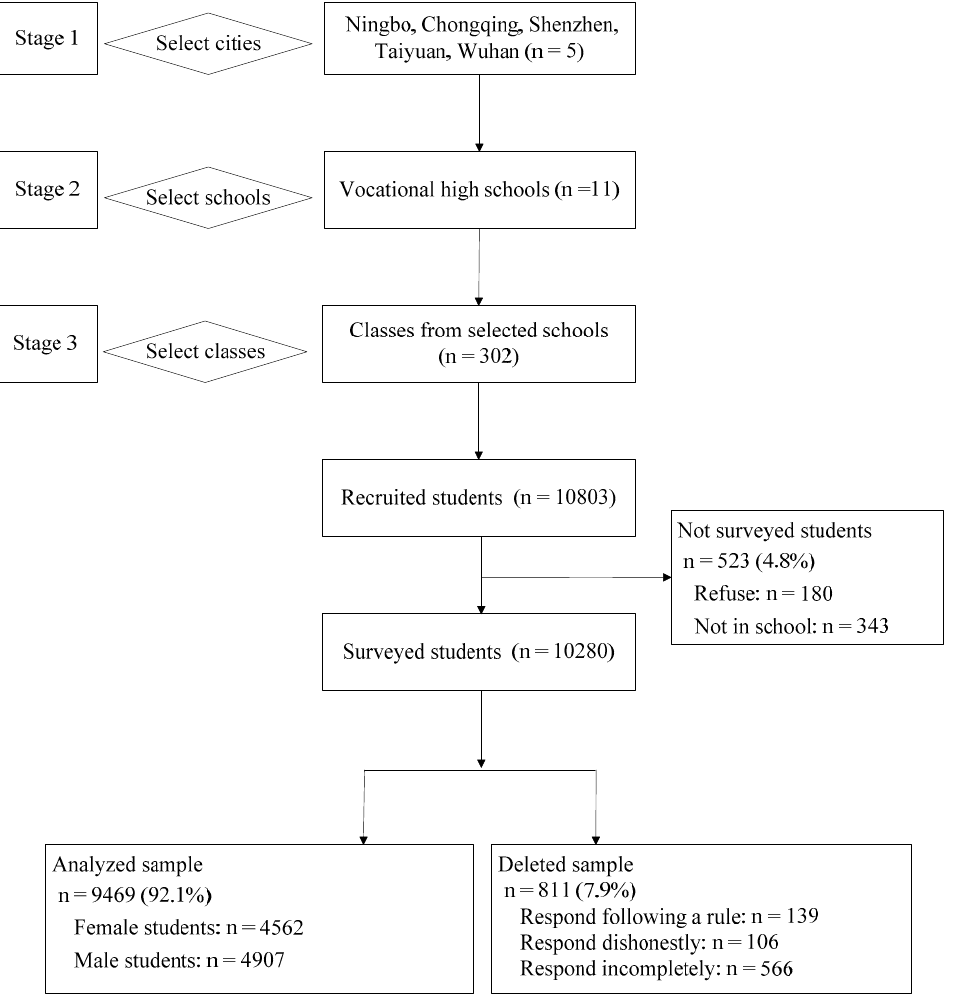
Figure 1. Flow chart for sampling process in the present study.